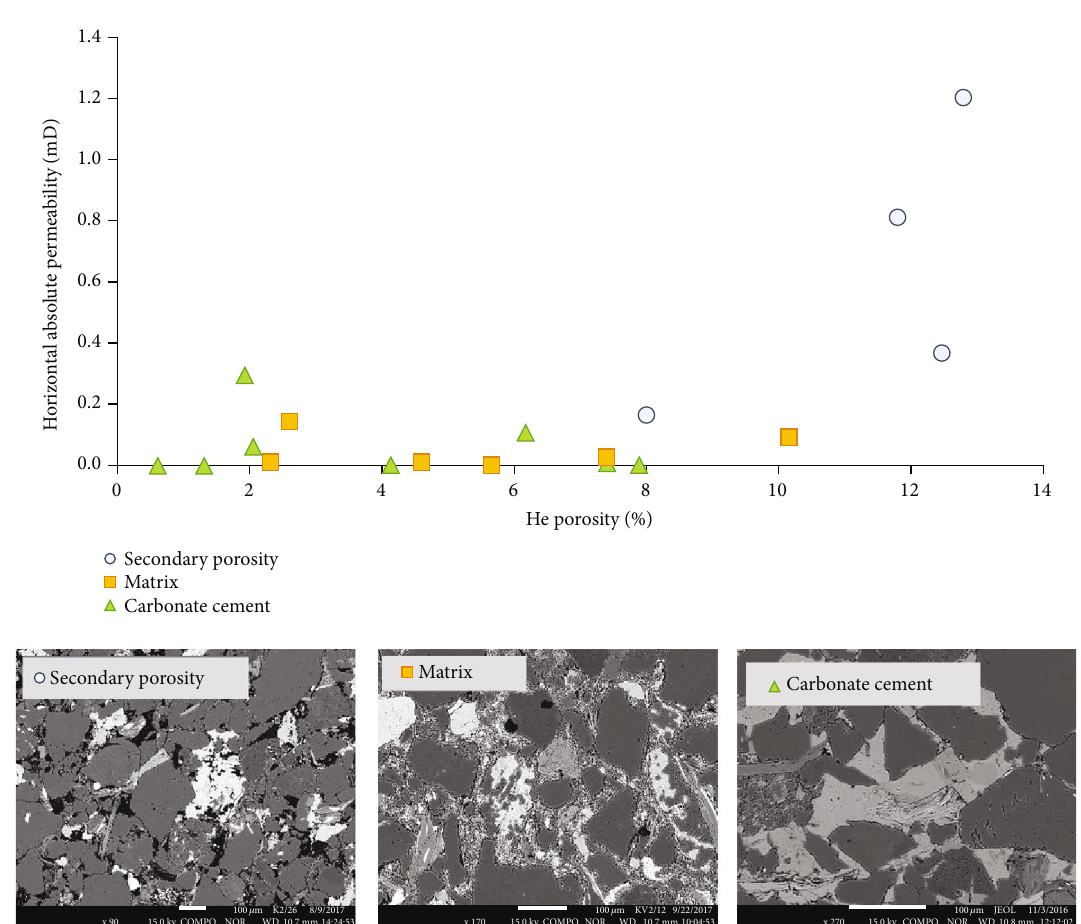
Figure 9: Classi fi cation of samples into three rock types in the analyzed sandstones. Relation of porosity and permeability and SEM images.